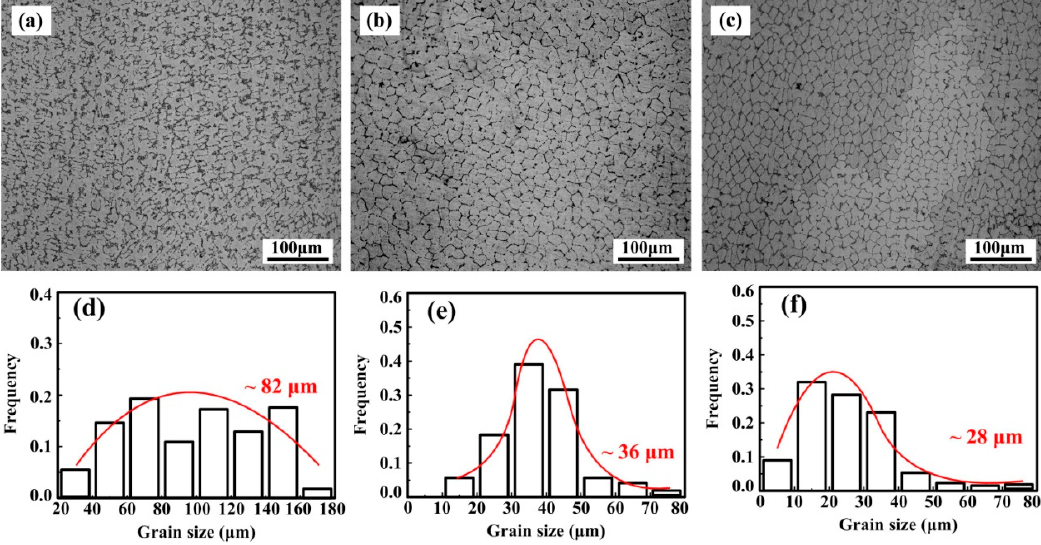
Figure 3. The morphologies of grain in ( a ) Cu–Cr–Zr alloys, ( b ) 2-wt %, ( c ) 4-wt % nano-sized TiCp-reinforced Cu–Cr–Zr composites and ( d – f ) the corresponding grain size distribution.